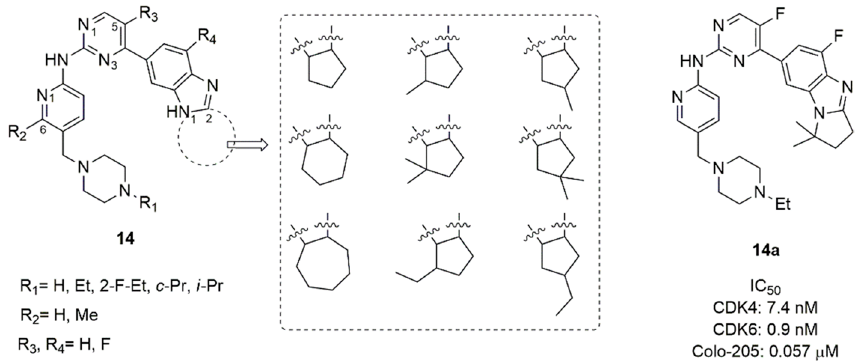
Figure 7. CDK4/6 inhibitors based on benzimidazolyl-cycloalkyl-pyrimidine scaffold.